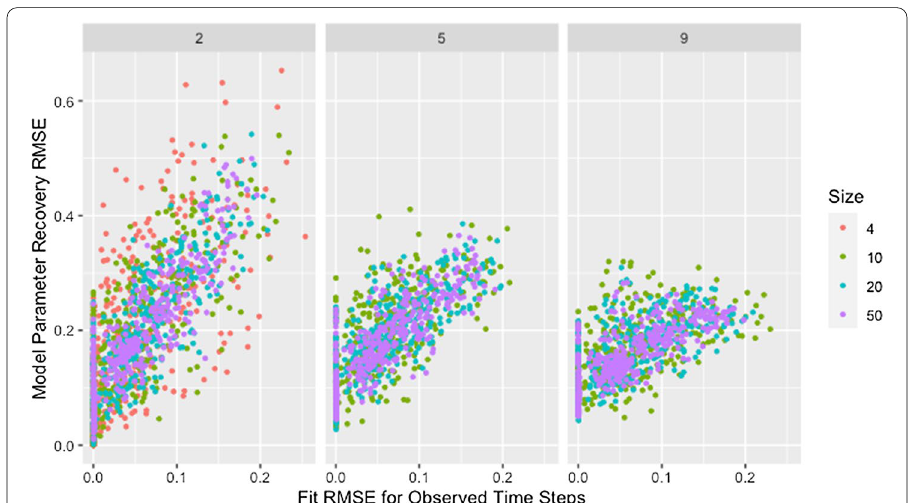
Fig. 3 RMSE for model parameter recovery by fit RMSE, size, and degree. RMSE for known and predicted weights by RMSE for observed and predicted opinions on observed time steps, network size, and target degree across